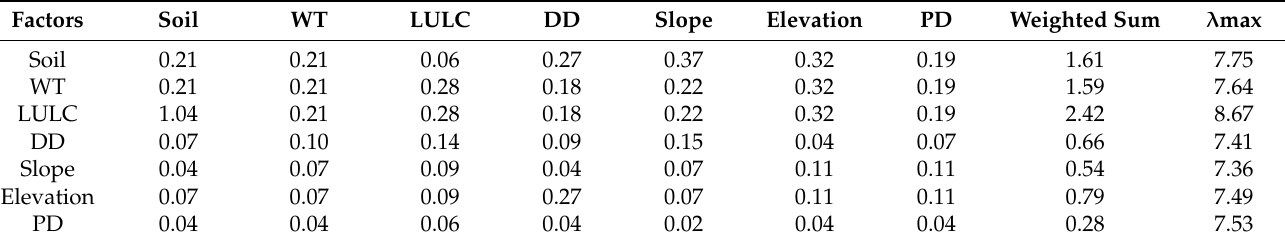
Table 5. Consistency Ratio